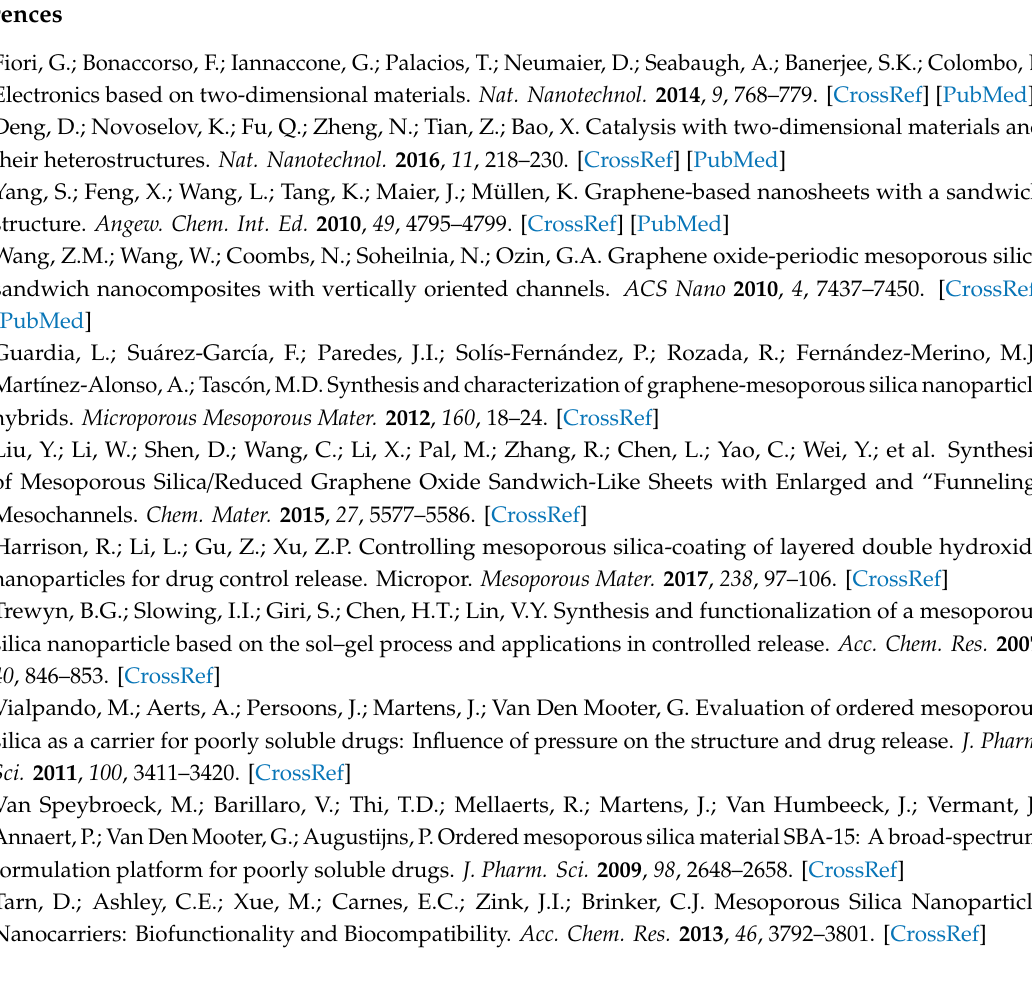
Figure S1: X-ray dispersion spectroscopy (EDX) elemental spectra of silica flakes and the templates; Figure S2: XRD patters of mSiO 2 after GO (A) and GO and mSiO 2 after LDH Mg / Al and LDH Mg / Al (B); Figure S3: Raman spectra of mSiO 2 after GO (A) and GO and mSiO 2 after LDH Mg / Al and LDH Mg / Al (B); Figure S4: BET isotherms (A) and diagrams of pore diameter distribution (B) of mSiO 2 after GO and mSiO 2 after LDH Mg / Al; Figure S5: Thermogravimetric analysis of silica flakes functionalized with folic